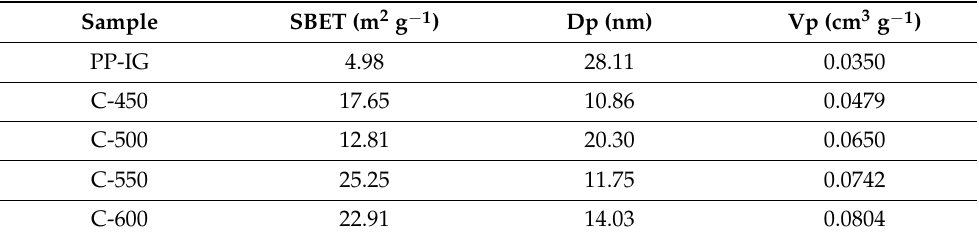
Table 6. Specific surface area and characteristics of the porous structure of raw PP-IG and yielded chars.